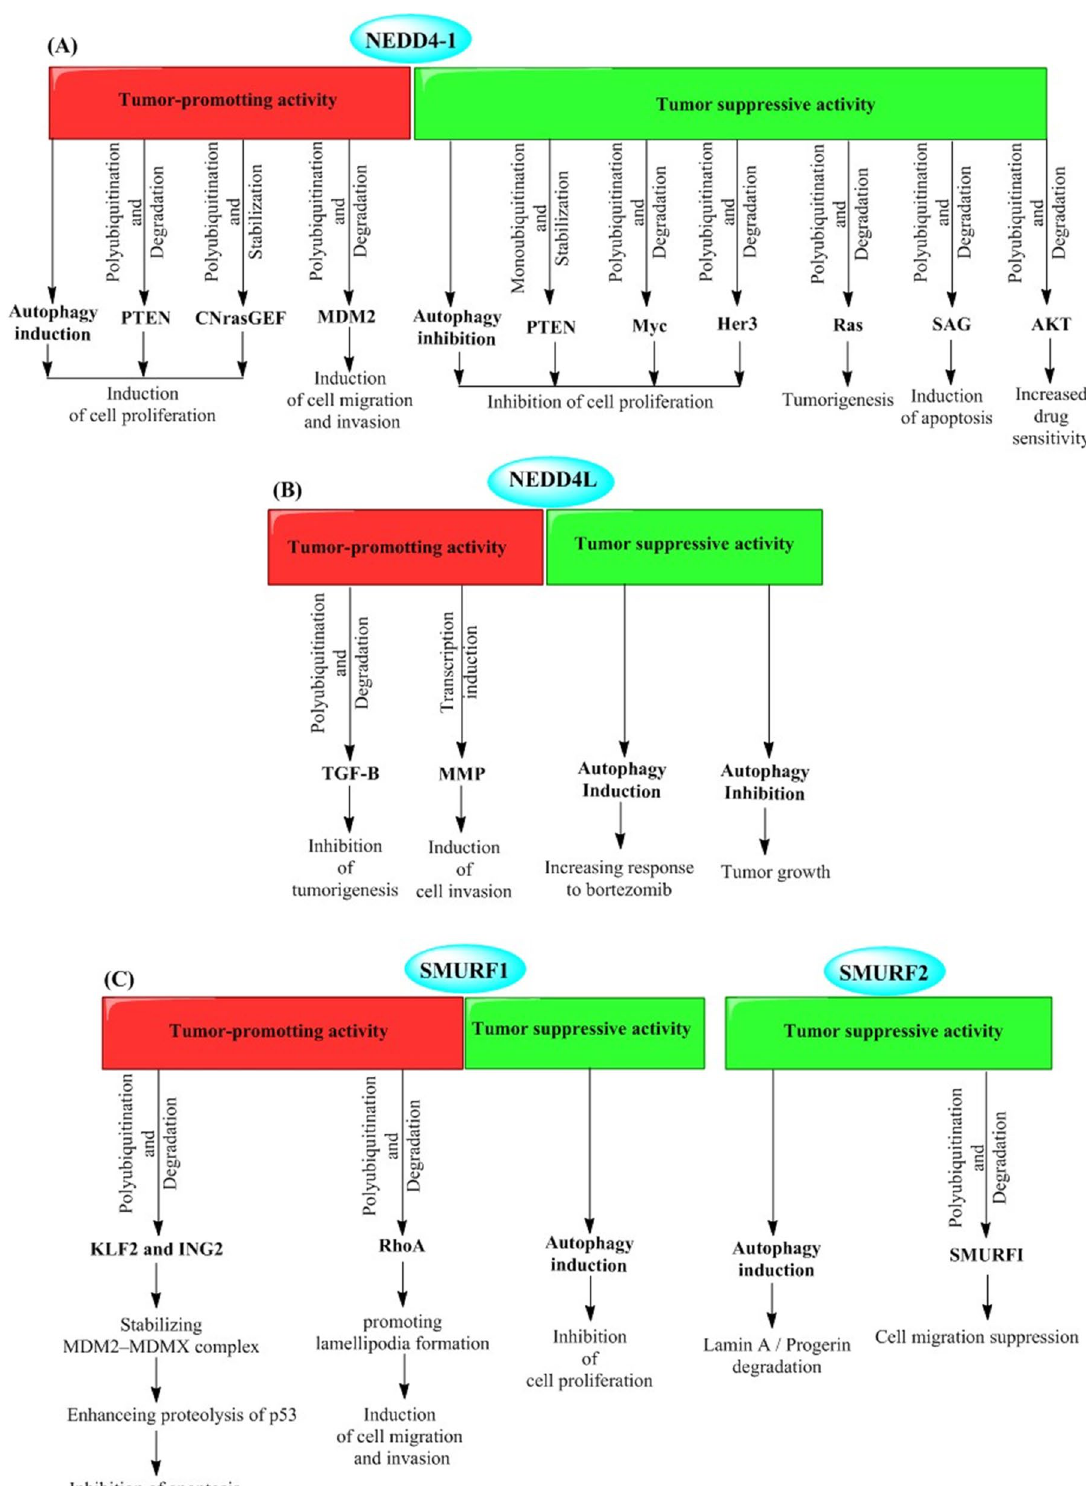
Fig. 2 Molecular targets and pathways involving tumor promoter and tumor suppressive activities of NEDD4 E3 ubiquitin ligases, including NEDD4-1 ( A ), NEDD4-L ( B ), SMURFs ( C ), WWP1 ( D ), and ITCH ( E